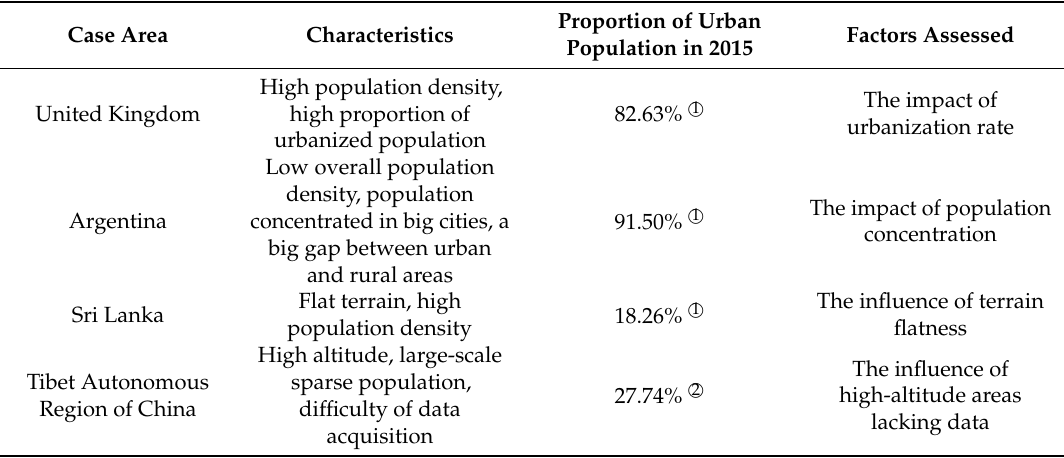
Table 1. Characteristics of each case